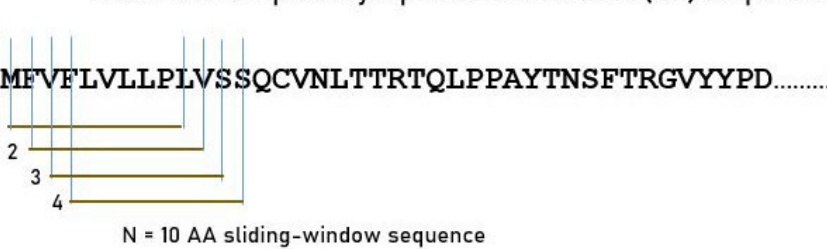
Figure 1. A sample of the sliding window approach for the SARS-CoV-2 S protein (see text for details)